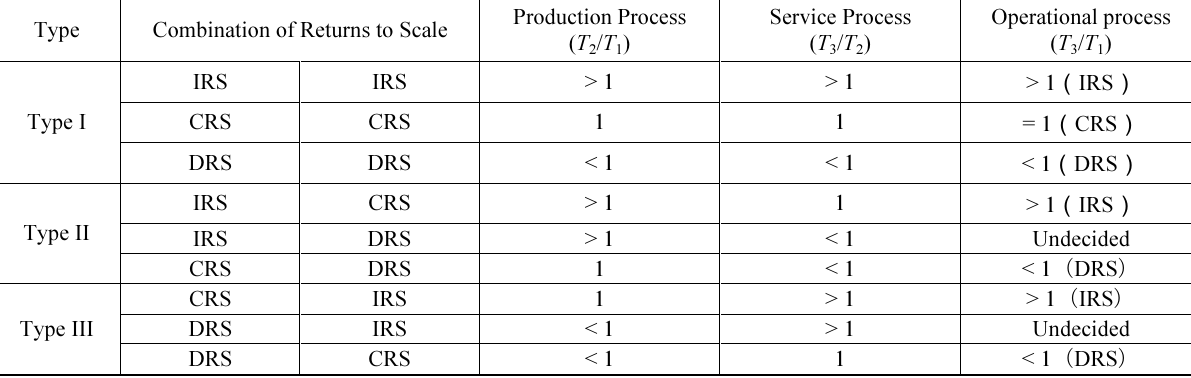
Table 1. The relationships of RTS between the Single-stage and Two-stage DEA model Type